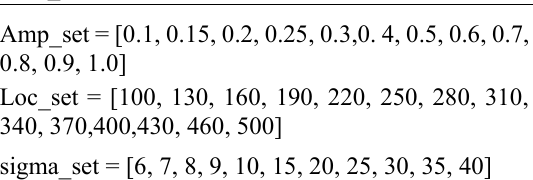
Table1. Parameters set of simulation full waveform signal